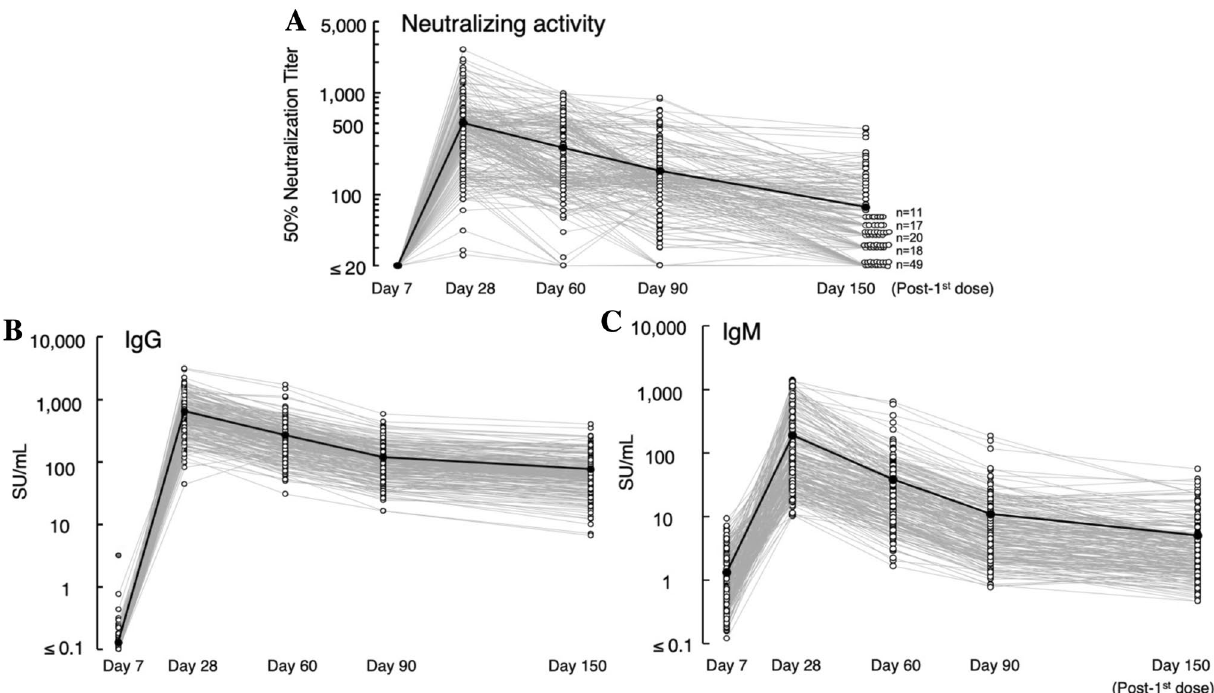
Figure 3. Kinetics of neutralizing activity and S1-binding-IgG and -IgM levels. Time-course analyses of neutralizing activity for 90 days were conducted. The 1st vaccine was administered on day 0, and the 2nd vaccine on day 21. Blood samples from vaccinated individuals were obtained on days 7, 28, 60, 90 and 150 post 1st dose as illustrated in Table 1. ( A ) Neutralizing activity is shown as NT 50 (50% neutralizing titer). The NT 50 value of 20 is the detection limit and values determined to be less than 20 were treated as 20. ( B , C ) Kinetics of S1-binding-IgG and -IgM levels are shown. The average values of each data point are shown in black solid circles, which are connected with solid black lines. One participant, who had been infected with SARS-CoV-2 with PCR-positivity documented, is indicated as a solid-red solitary circle in ( B ) and ( C ). This participant was excluded from all analyses at later